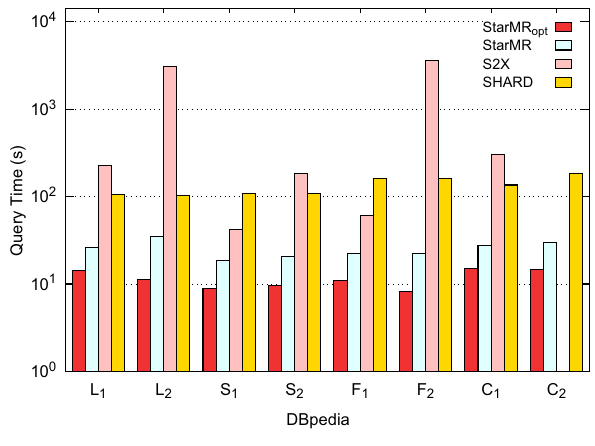
Fig. 11 Efficiency on